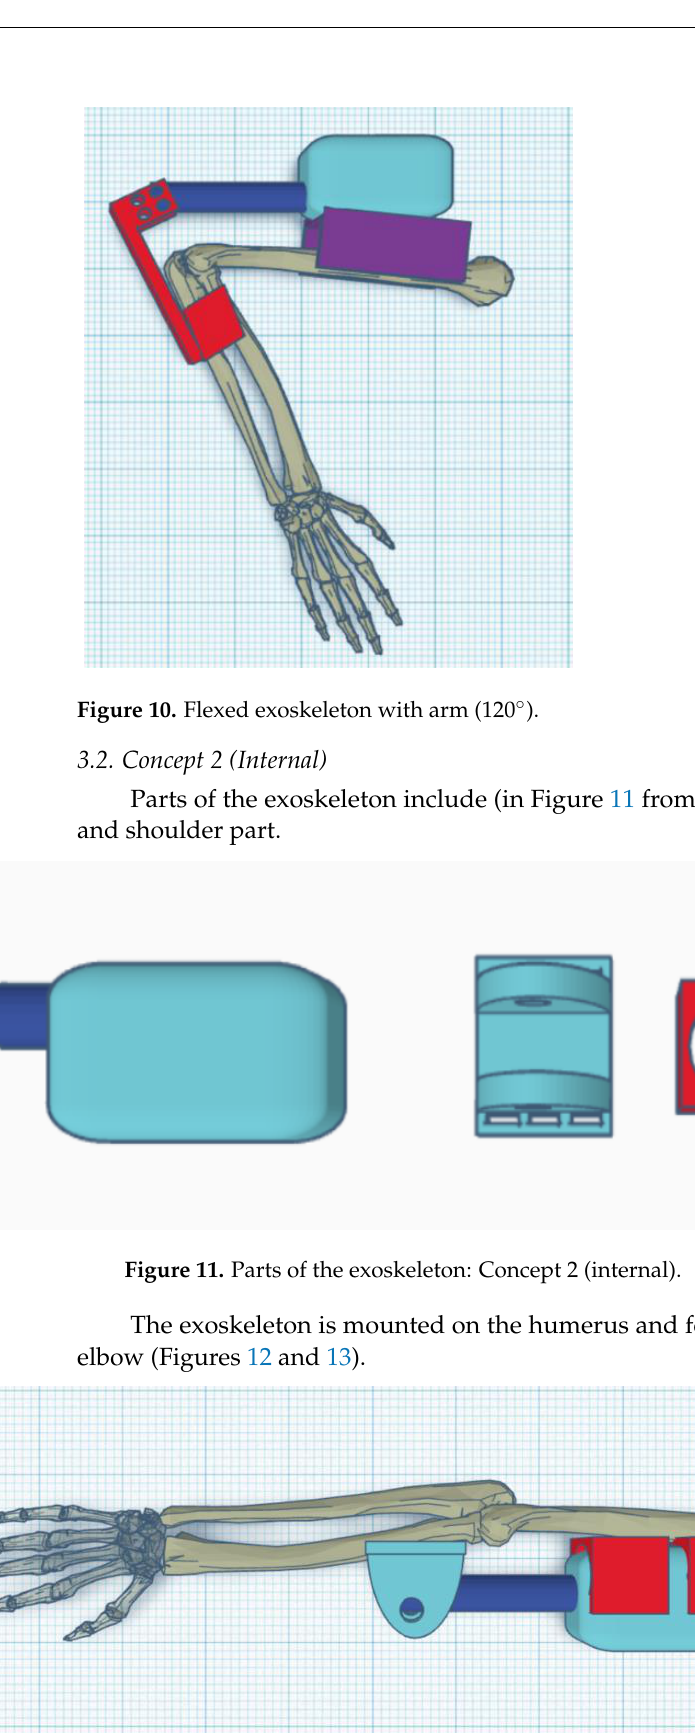
Figure 12. Upright exoskeleton with arm (0 ).